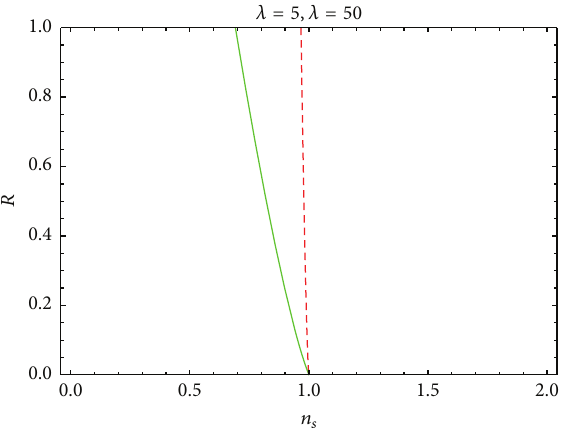
Figure 11: Tensor-scalar ratio in terms of spectral index 𝑛 𝑠 , ] = 50 by dashed line and ] = 5 by green line.